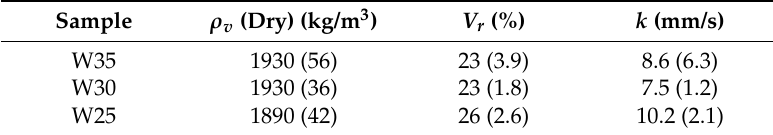
Table 4. Results of unit weight, void content, and hydraulic conductivity, including standard